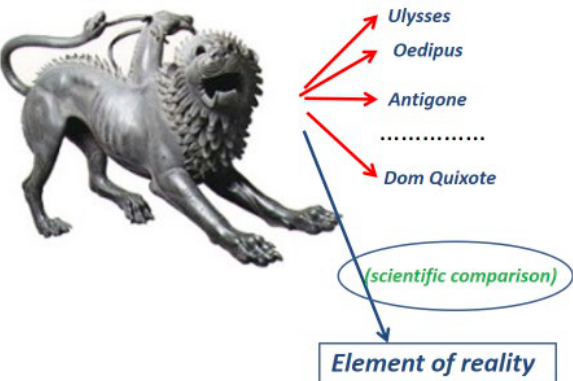
Figure 14. Two kinds of interpretation of a text, or hermeneutics, namely, the CIRCLE, whereby the interpreter A attributes a finite and fixed set of meanings to the text B, and the COIL, whereby A captures some particular aspects of B and-based on that informa- tion- A approaches again the text B discovering new meanings. The novel insight provided at each coil is an indication of how language provides new semantic apertures.